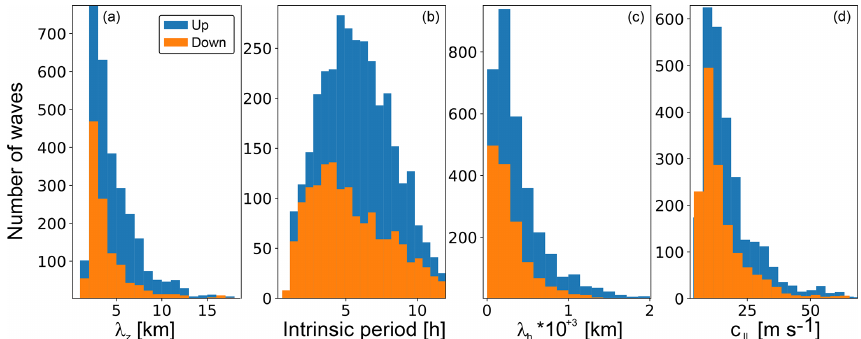
Figure 12. Histograms of different GW properties separated for upward- and downward-propagating waves. (a–d) vertical wavelength, intrinsic period, horizontal wavelength and horizontal phase speed, estimated from Eqs. (1), (A5), (A9) and (a), respectively.